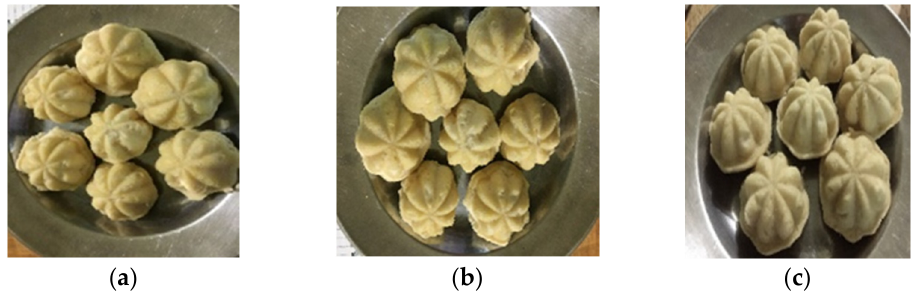
color. The liquid color of Bahulu samples N and P was green, producing light-green foam.